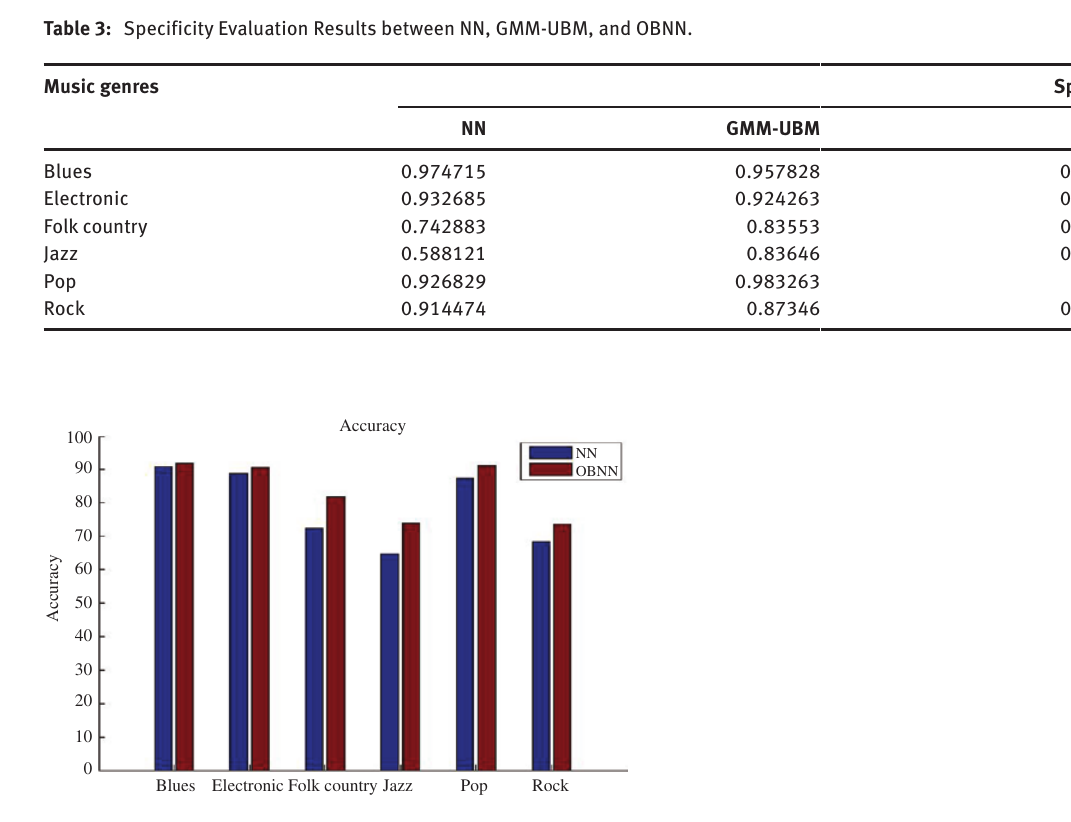
Figure 2: Accuracy Comparisons of the Proposed and Existing Methods.